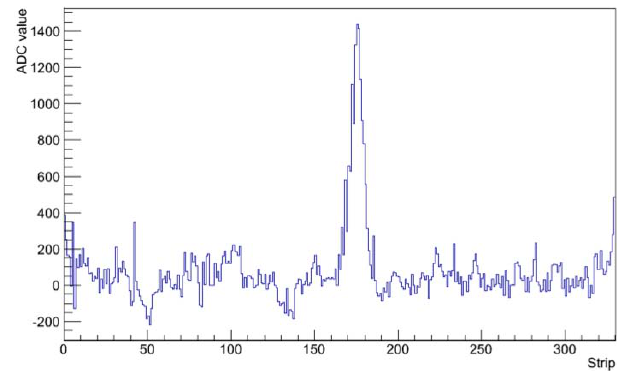
Fig. 5. Intrinsic detector resolution σ intr in mm vs. detector position.